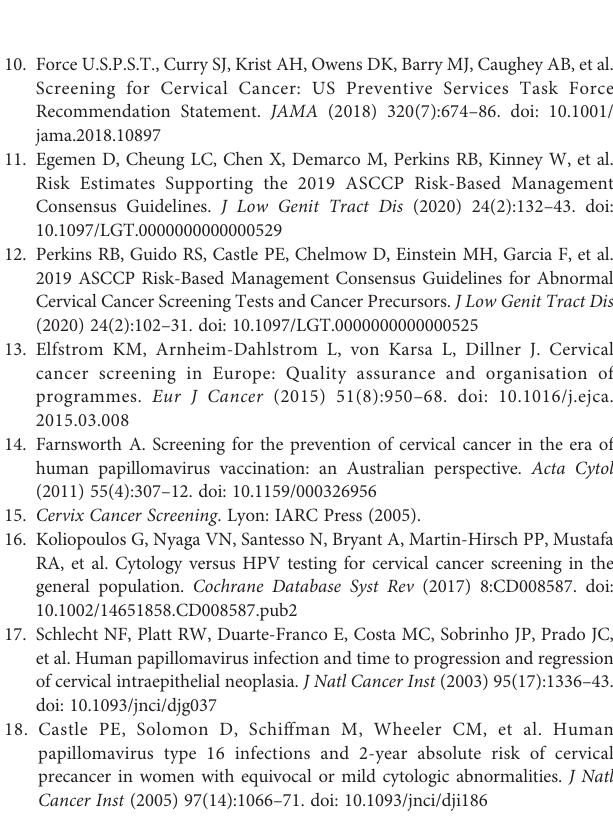
Supplementary Figure 1 | (A) The number of productive templates obtained for each sample. Number is shown on the y-axis, and result category is shown on the x-axis. The horizontal dotted line indicates a template count of 5000. Other details are as described for Figure 3A . (B) The number of productive rearrangements obtained for each sample. Other details as in Panel (A) . (C) The Fraction Productive of Cells Mass Estimate, referred to as the Estimated T cell Fraction, obtained for each sample. Other details as in Panel A. Supplementary Figure 2 | (A) The number of productive templates obtained for eachsample.Numberisshownonthey-axis,andHPVinfectionstatusaccordingto the Roche Linear array is shown on the x-axis. Samples are classi fi ed as positive if they are positive for one or more HPV types. A test for difference in the median value between the two groups was conducted using a Mann-Whitney test. p values are reported when p ≤ 0.05. (B) Thenumberof productiverearrangements obtainedfor each sample. Other details as in Panel (A) . (C) The Fraction Productive of Cells Mass Estimate, referred to as the Estimated T cell Fraction, obtained for each sample. Other details as in Panel (A) . Supplementary Figure 3 | (A) The percentage of productive templates that correspond to a unique nucleotide sequence (Percent Unique) obtained for each sample. Percentage is shown on the y-axis, and result category is shown on the x- axis.Other detailsare asdescribed for Figure3A . (B) Therelativeabundance ofthe largest clone (Largest Clone Size) obtained for each sample. Other details as in Panel (A) . (C) The Productive Clonality (1 – normalized Shannon Entropy) obtained for each sample. Other details as in Panel A. Supplementary Figure 4 | (A) The percentage of productive templates that correspond to a unique nucleotide sequence (Percent Unique) obtained for each sample. Percentage is shown on the y-axis, and HPV infection status according to the Roche Linear array is shown on the x-axis. Other details are as described for Supplementary Figure 2A . (B) The relative abundance of the largest clone (Largest Clone Size) obtained for each sample. Other details as in Panel (A) . (C) The Productive Clonality (1 – normalized Shannon Entropy) obtained for each sample. Other details as in Panel (A)